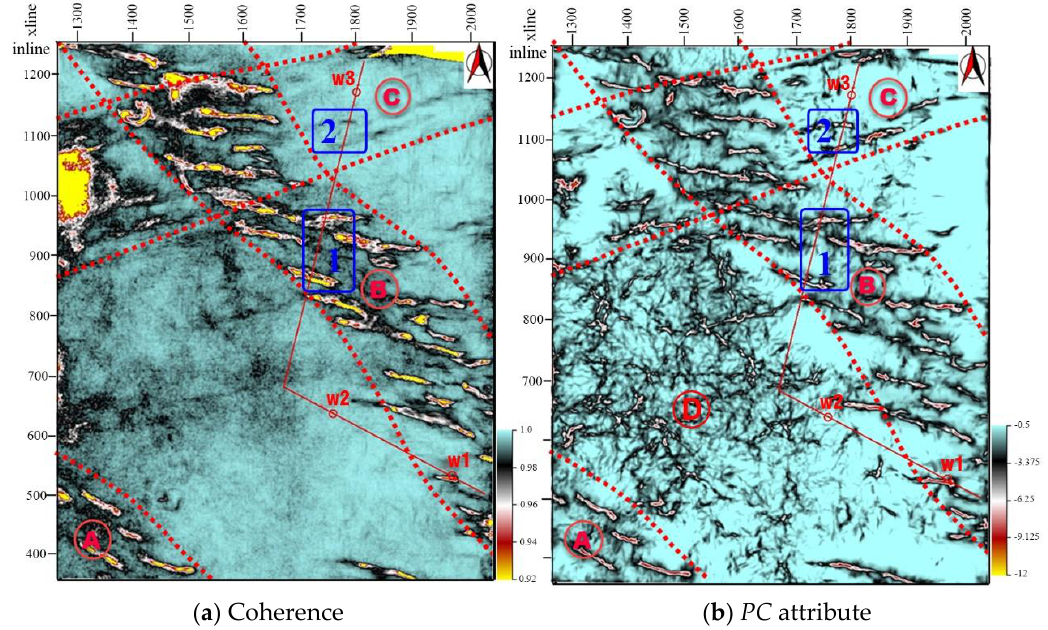
Figure 6. Comparison of coherence and its PC result of target stratum. There are two known zones for geologists (zone Ⓐ and Ⓑ ), one estimated zone (zone Ⓒ ), and a newly discovered fault zone (zone Ⓓ ). Furthermore, there are two areas, named “1” and “2”, for comparison shown in blue frames. ( a ): the coherence of target stratum. ( b ): the PC result extracted from ( a